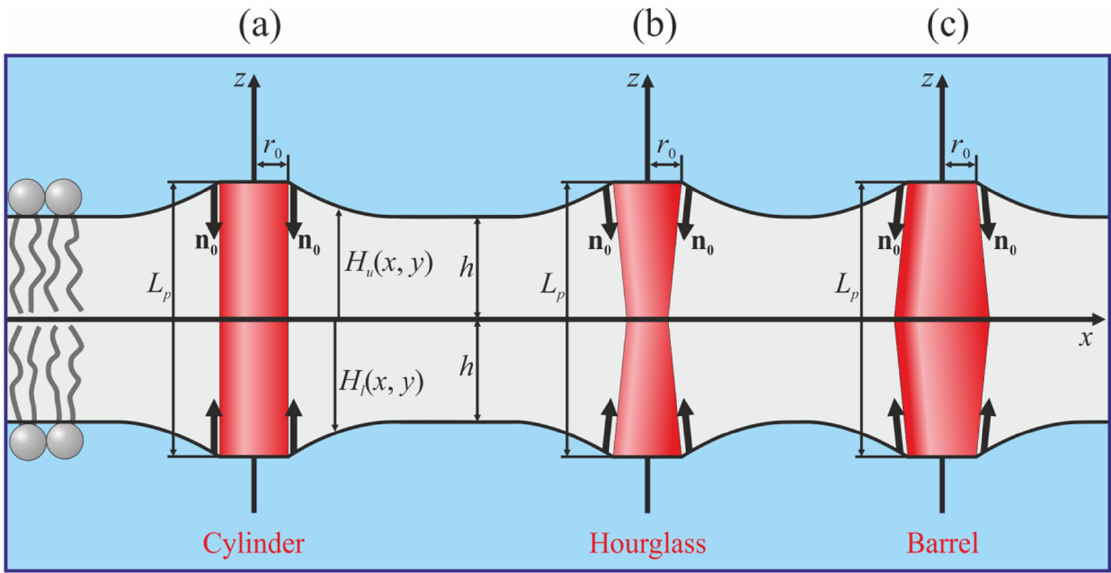
Figure 1. Schematic representation of the cylindrical ( a ), hourglass-like ( b ) and barrel-like ( c ) TMDs incorporated into the lipid membrane. Parameterization of elastic deformations of the membrane and boundary conditions at the TMDs are illustrated.